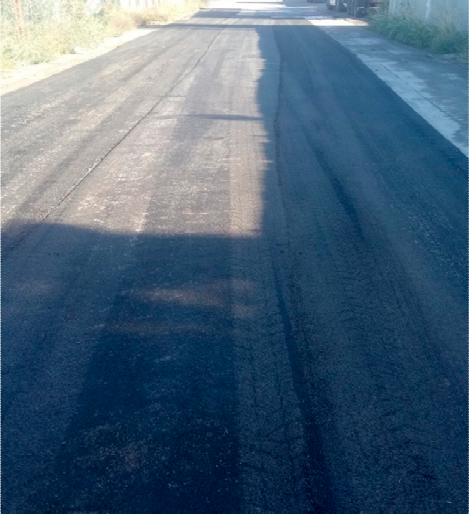
Figure 8. First short test section at the asphalt plant (MTM1) constructed during technological trials described in Section 3.6–September 2018.